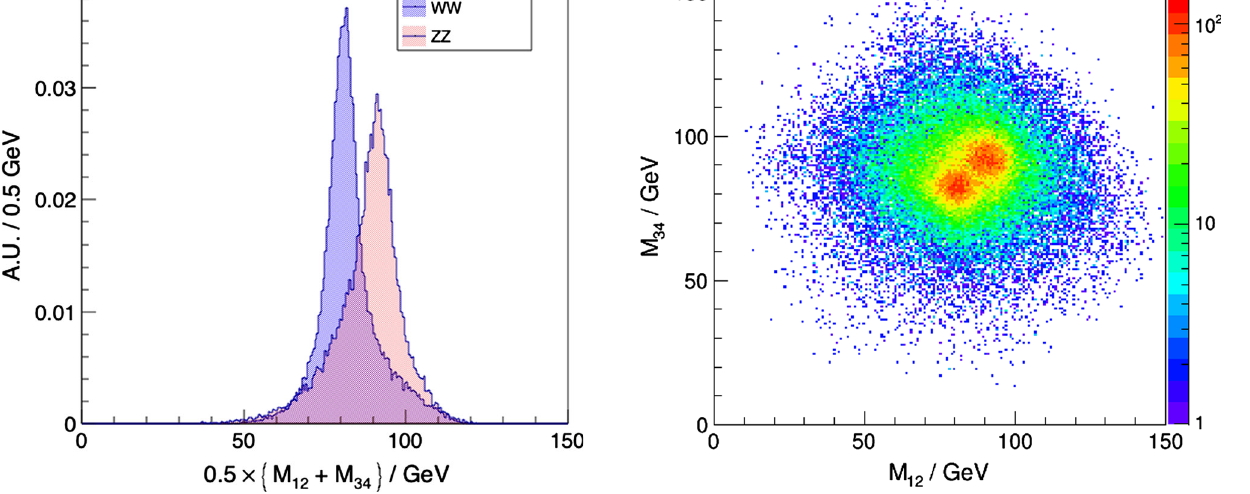
Fig. 5 The RecoJet level distributions of 0 . 5 × ( M 12 + M 34 ) of the WW and ZZ events. The overlapping fraction is 57 . 8% ± 0 . 23%